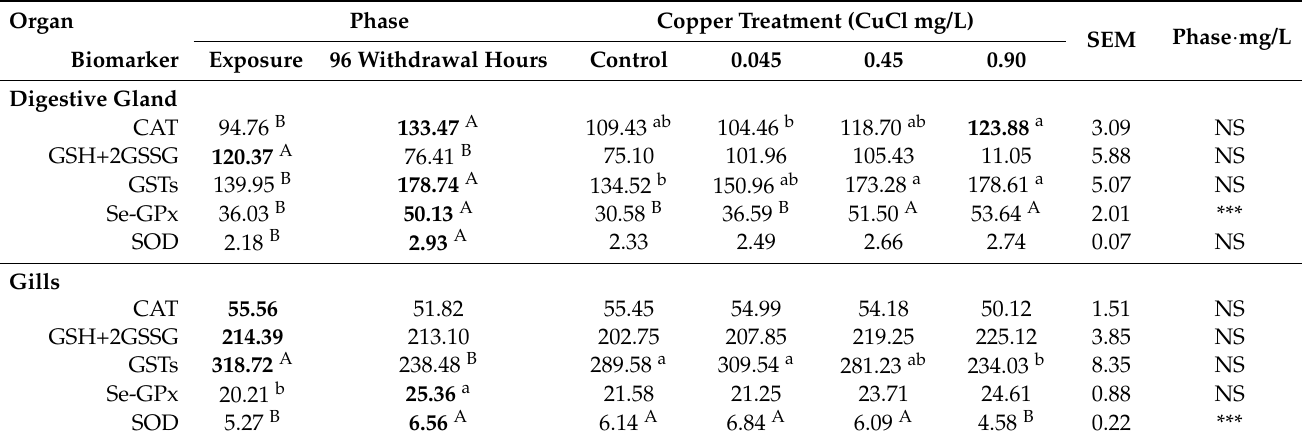
Table 1. Estimated means of the biomarkers used during copper treatment and post copper treatment and in the four different concentrations.